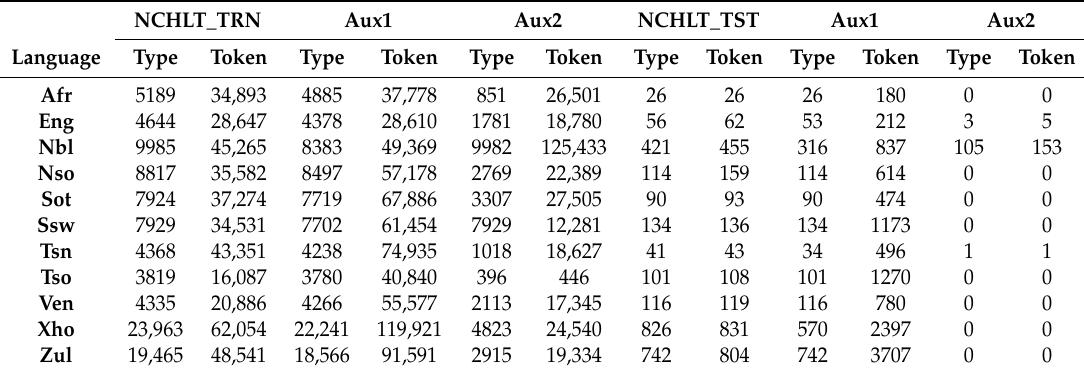
Table 4. Type and token counts for words only in NCHLT_TRN and only in NCHLT_TST. Aux1, Aux2: Type and token counts for words repeated in auxiliary data.